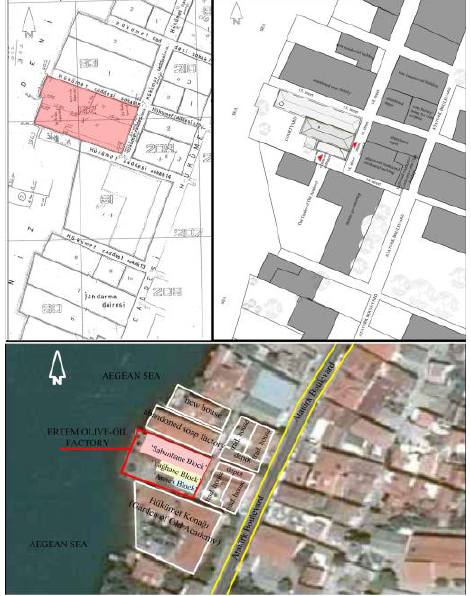
Figure 4 : Top Left: cadastral plan (obtained from municipality); Top Right: site plan (prepared by the author, 2016), Bottom: physical layout of the building (Google Earth image, 2016 is digitally manipulated by the author) The building lot (See Figure 4) which is located on 14. Street, Sakarya District in Ayvalık/Balıkesir-Turkey, covers an area of 1125 m², of 582 m² which is occupied by the factory.